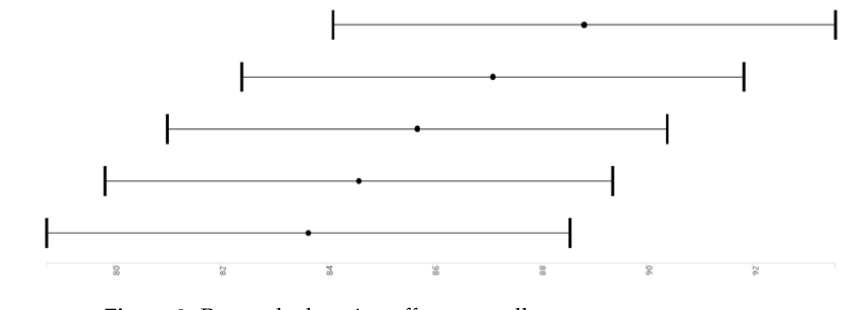
Figure 2. Parental education e ff ects overall.